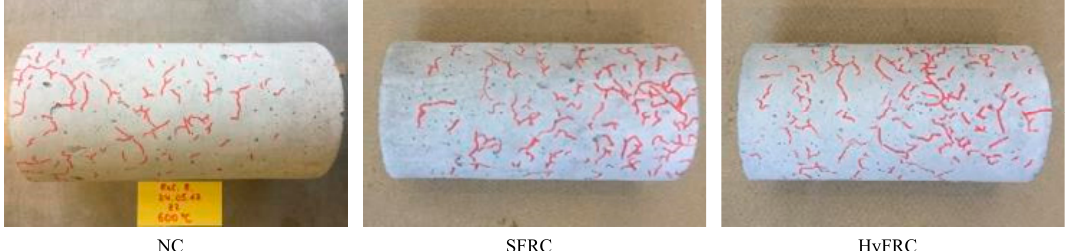
Figure 5. Typical thermal cracks observed for the cylinders used for split tensile strength tests after exposure to maximum temperature of 600 °C.